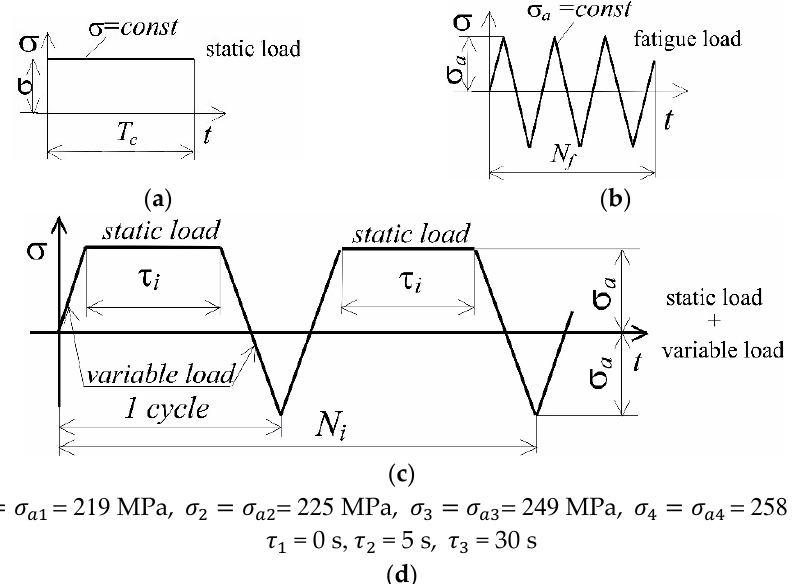
Figure 2. Load programs: ( a ) static load, ( b ) fatigue load, ( c ) static load + fatigue load, ( d ) load parameters.